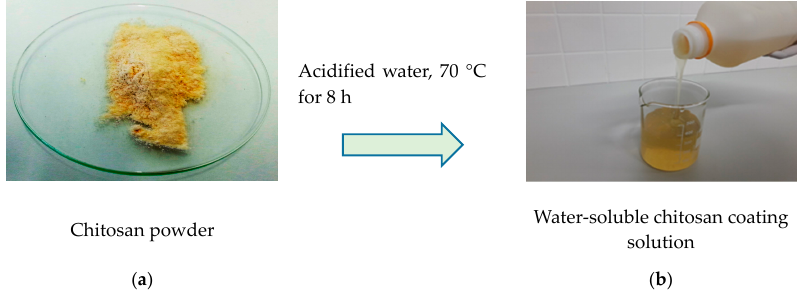
Figure 1. Chitosan powder in its native form ( a ) and chitosan fully dissolved in water, used for surface treatment of the fibre-based substrate ( b ).